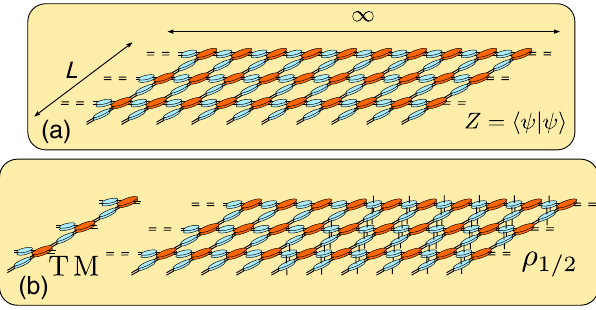
FIG. 22. (a) The setup used in our numerical calculations. Each of the elementary tensors C (cyan) and G (orange) has bond dimension D ¼ 2 , and its matrix elements are those described in the main text. The elementary tensors are contracted, so as to provide the quantum states j ψ i of a 2D infinitely large cylinder of circumference L . In the drawing, one has to assume periodic boundary conditions along the vertical direction. Here, we represent the norm of the state that defines the partition function Z of a 2D classical model. (b) We compute the spectrum of the TM across the cylinder (sketched on the left), which characterizes the decay of the correlations addressed in Sec. XI A, and the spectrum of the reduced density matrix of half of the cylinder ρ 1 (shown on the right), which gives access to the entanglement characterization of the states addressed in Sec. XI B. Both calculations are performed via sparse exact diagonalization, and their costs increase exponentially with L , so that we can address at most systems with L ¼ 20